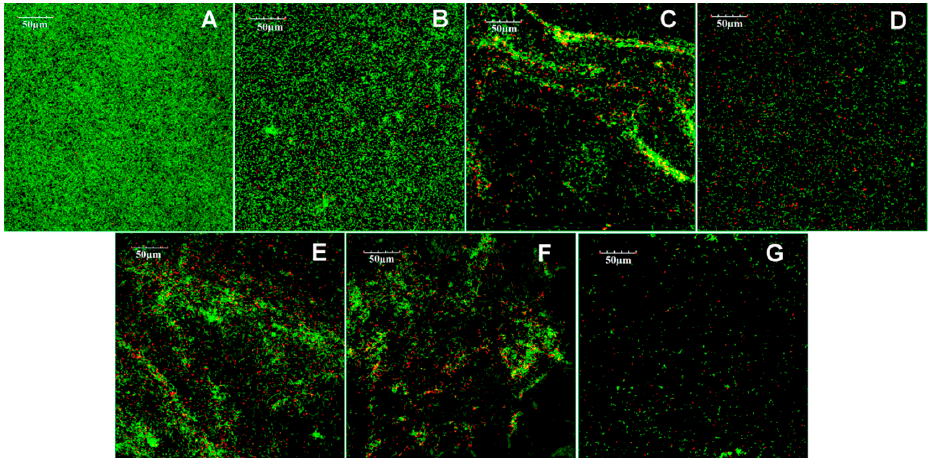
Figure 4. Confocal laser scanning microscope images of the Streptococcus mutans biofilms on the specimens: SB 2 ( A ); EGCG 200 ( B ); EGCG 400 ( C ); EGCG 600 ( D ); EGCG-3Me 200 ( E ); EGCG-3Me 400 ( F ); and EGCG-3Me 600 ( G ). Green fluorescence indicates the live bacteria and red fluorescence indicates the dead bacteria. EGCG 200, 400, and 600, epigallocatechin-3-gallate at 200 µg/mL, 400 µg/mL, and 600 µg/mL, respectively; EGCG-3Me 200, 400, and 600, epigallocatechin-3- O -(3- O -methyl)-gallate at 200 µg/mL, 400 µg/mL, and 600 µg/mL, respectively; SB 2, Single Bond 2 (3M ESPE, St. Paul. MN, USA).